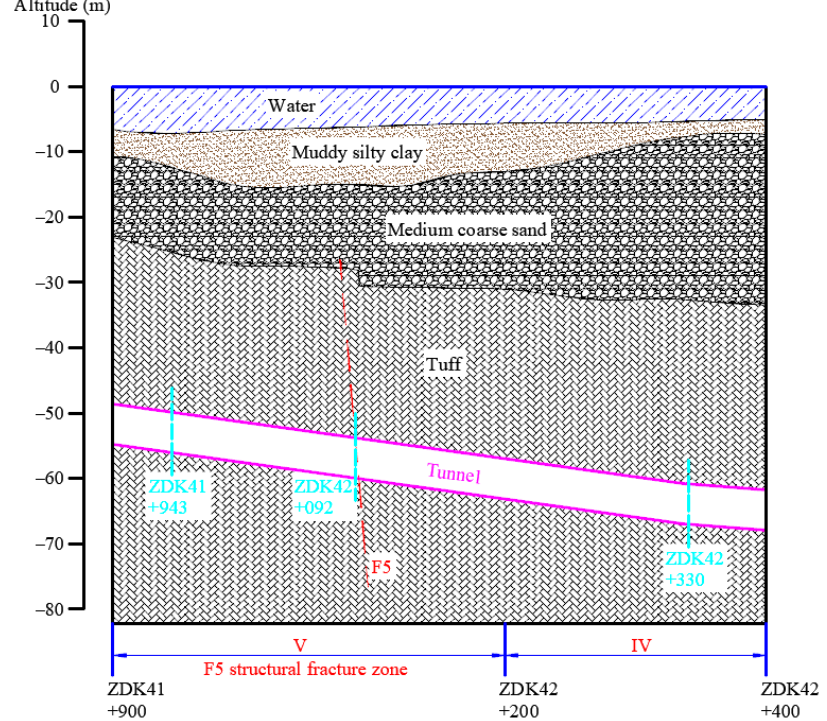
Figure 2. Local geological profile near the tunnel monitoring section. Table 2. The statistics of monitoring sections.